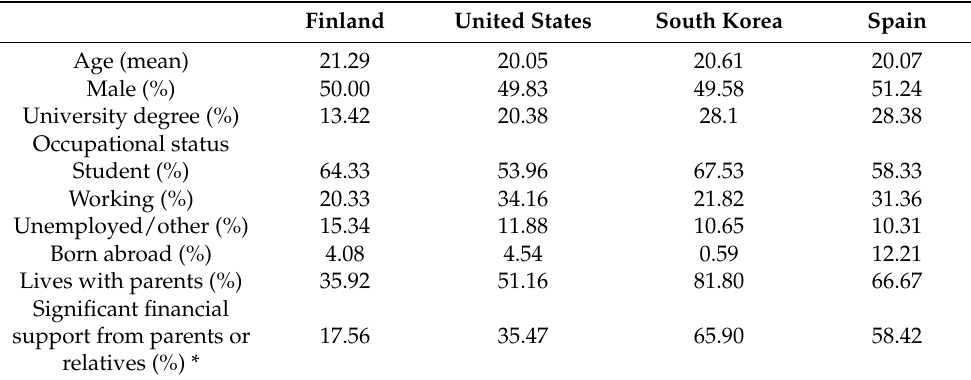
Table A1. Descriptive statistics of the study participants.